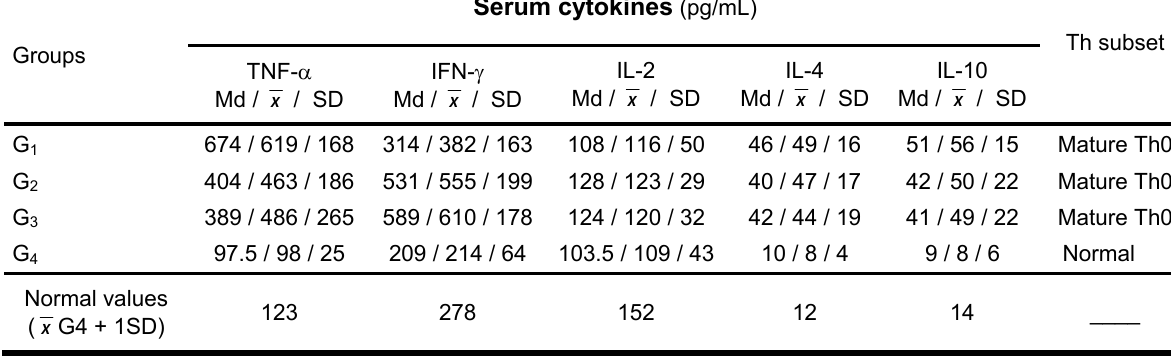
Table 2. Distribution of serum cytokine values by group (ELISA)